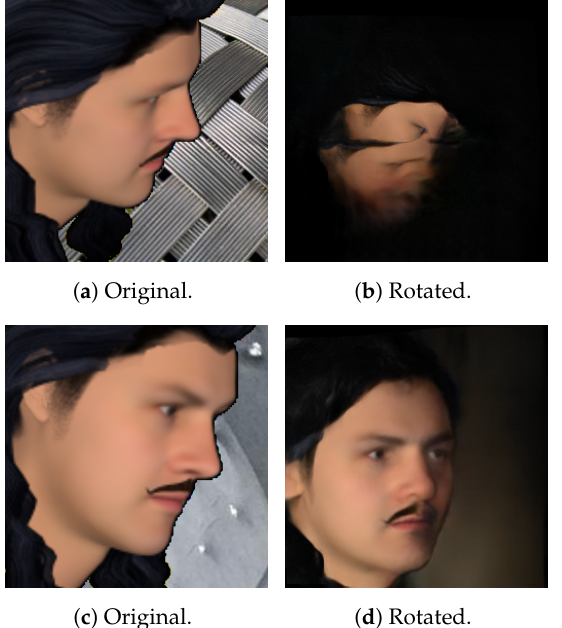
Figure 25. The same subject from two different angles and the corresponding attempts at synthetic rotation. On the top is an unnatural result and on the bottom a “proper”